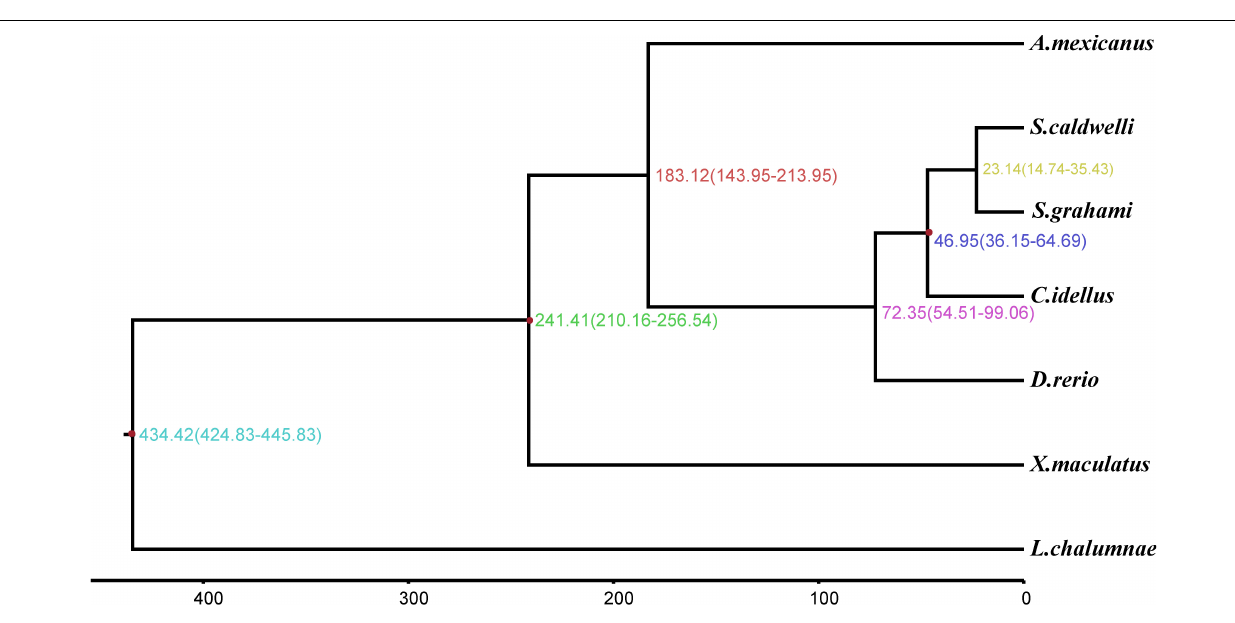
FIGURE 5 | The phylogenetic tree and molecular timing of S. caldwelli and other fish species, showing S. caldwelli had diverged 23.4 million years ago. A total of 13,568 fourfold degenerate positions are used to compute the tree and infer the divergence